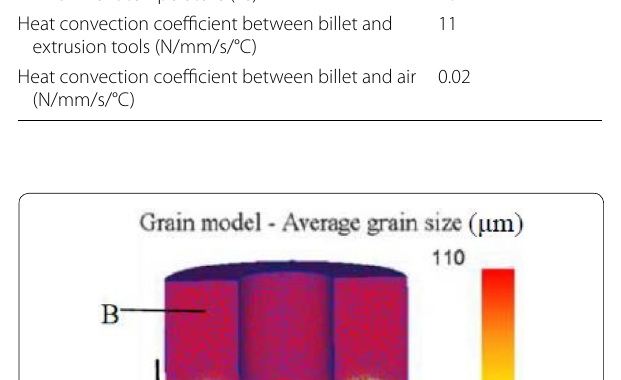
Figure 12 Sample points for grain size